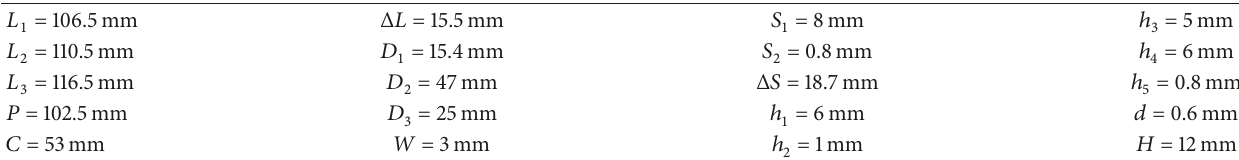
Figure 1: Geometry of proposed antenna. (a) 3D structure; (b) top view; (c) side view (hide vertical slotted ground). 𝐻 is the total height of the five layers, 𝐻 = ℎ 1 + ℎ 2 + ℎ 3 + ℎ 4 + ℎ 5 , and dielectric constant 𝜀 𝑒 = 4.4 . Table 1: Values of proposed antenna